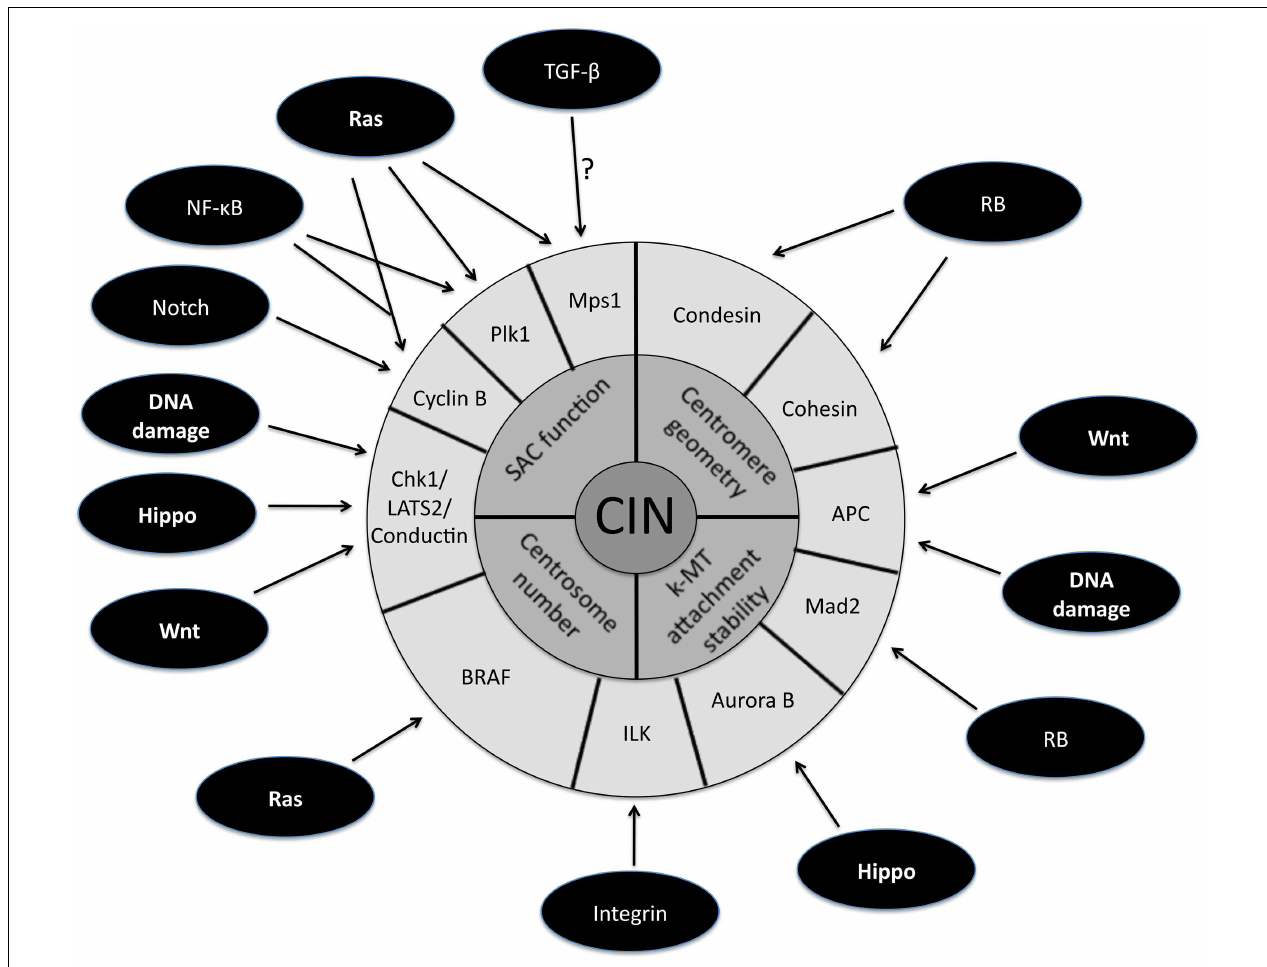
targets of oncogenic pathways involved in the four primary CIN-causing mitotic defects comprise the outer circle. Note that some downstream targets (e.g., APC) have been demonstrated to play a role in more than one CIN-causing mitotic